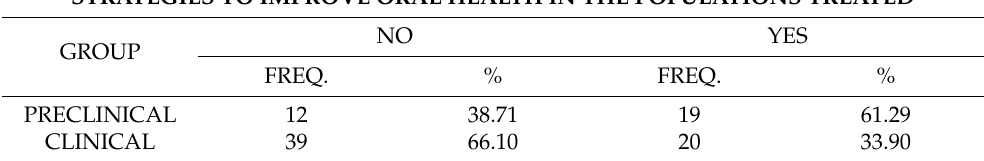
Table 11. Differences between groups on the strategies to improve oral health in the populations intervened. ( p =